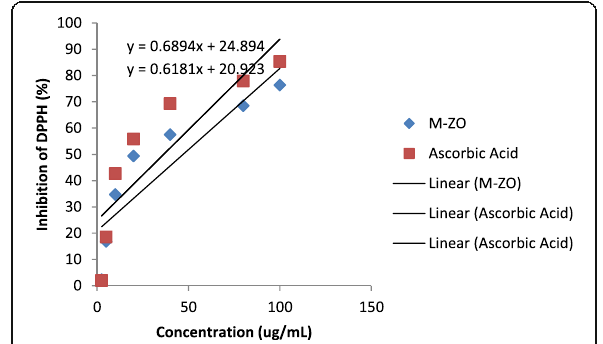
Fig. 1 Dose dependent DPPH scavenging activities of MZO